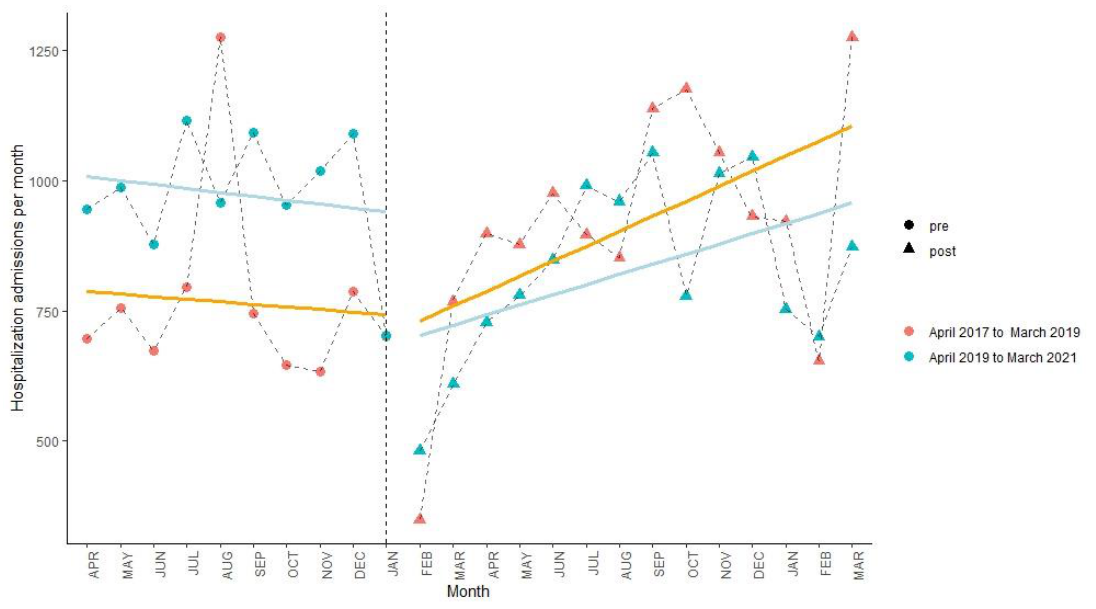
Figure 4. Interrupted time series analysis of hospital visits outside Yangjiang City from April 2017 to March 2019 (orange line) and from April 2019 to March 2021 (blue line). The line is the model fit and the vertical dashed line indicates the intervention (23 January 2020). Table 4. Overall controlled interrupted time-series analysis: negative binomial regression on monthly hospital visits adjusted for seasonal